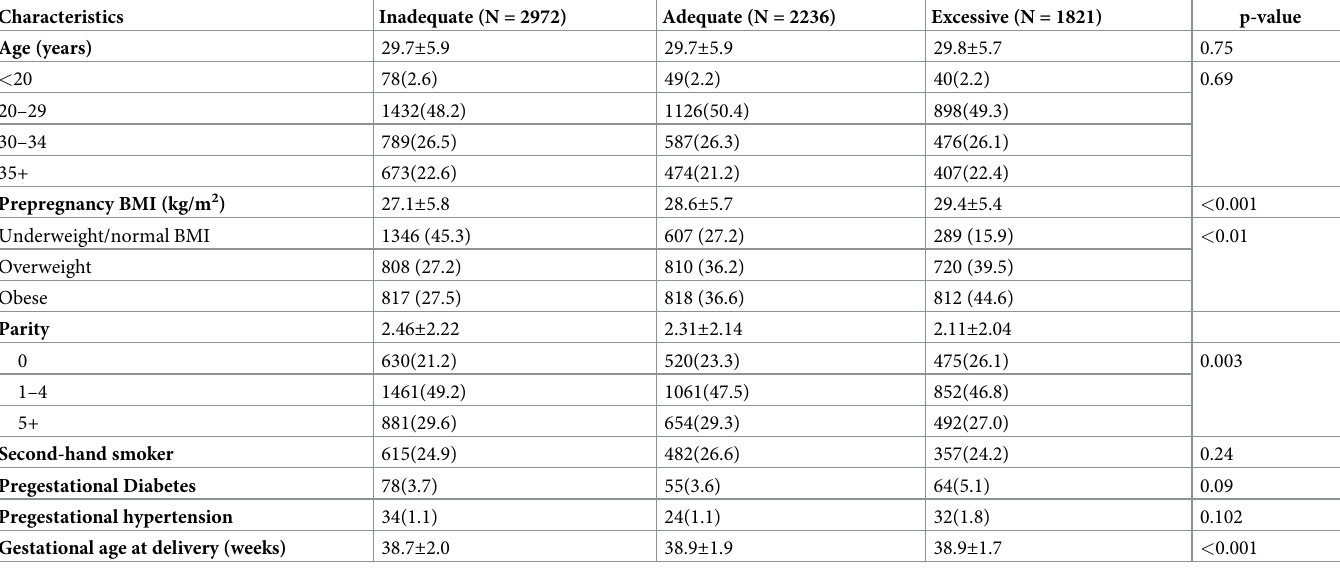
Table 1. Participant characteristics by institute of medicine gestational weight gain